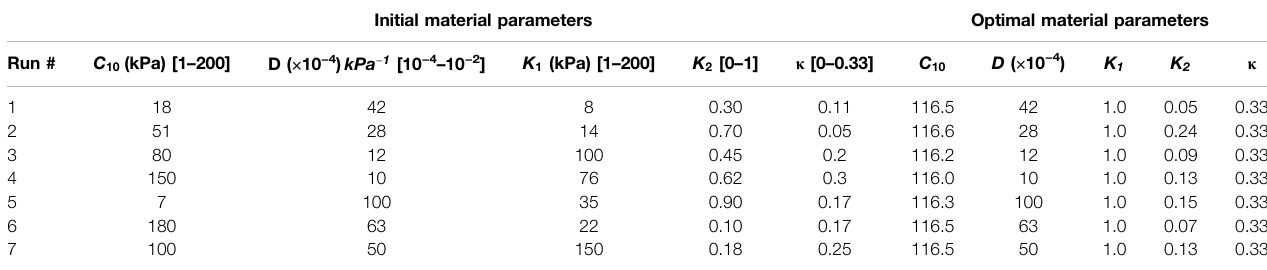
TABLE 2 | Sets of initial estimates and converged optimal material parameters for the homo/aniso/hyper case. In order to avoid local minimum, the optimization routine was repeated from seven different starting points. Initial material parameters Optimal material